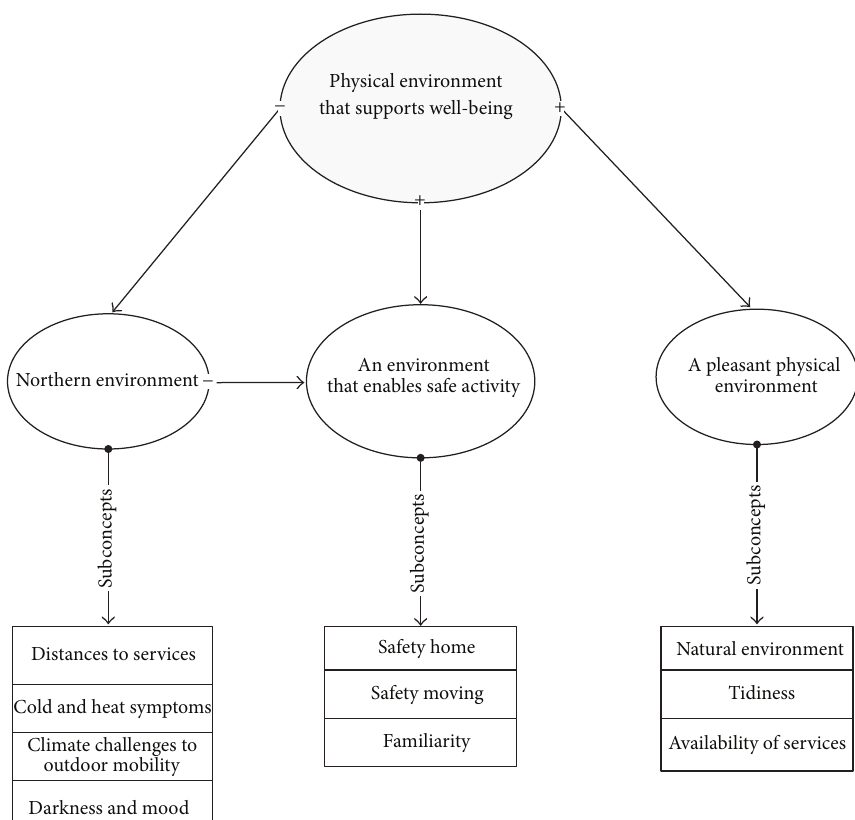
Figure 2: An example of a hypothetical